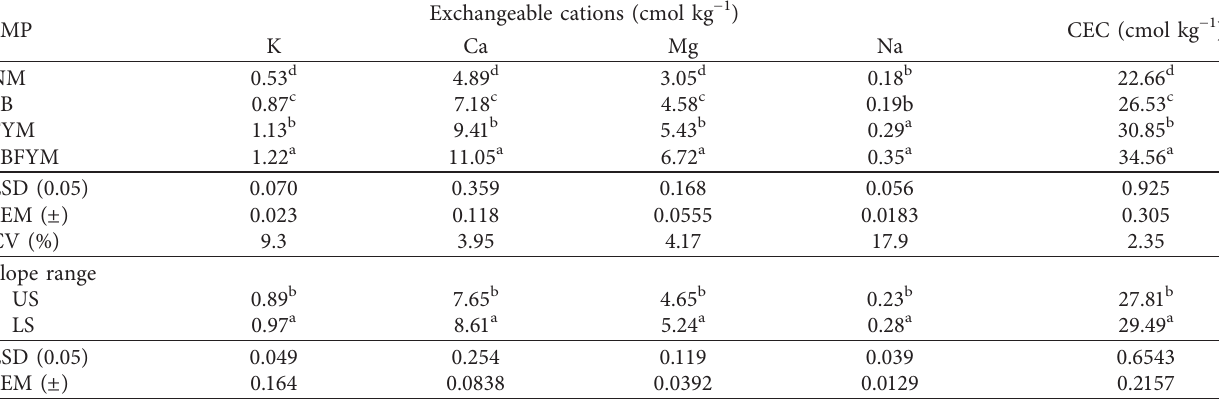
Table 6: Effect of soil management practices and slope ranges on exchangeable cations in soils of Mawula watershed.